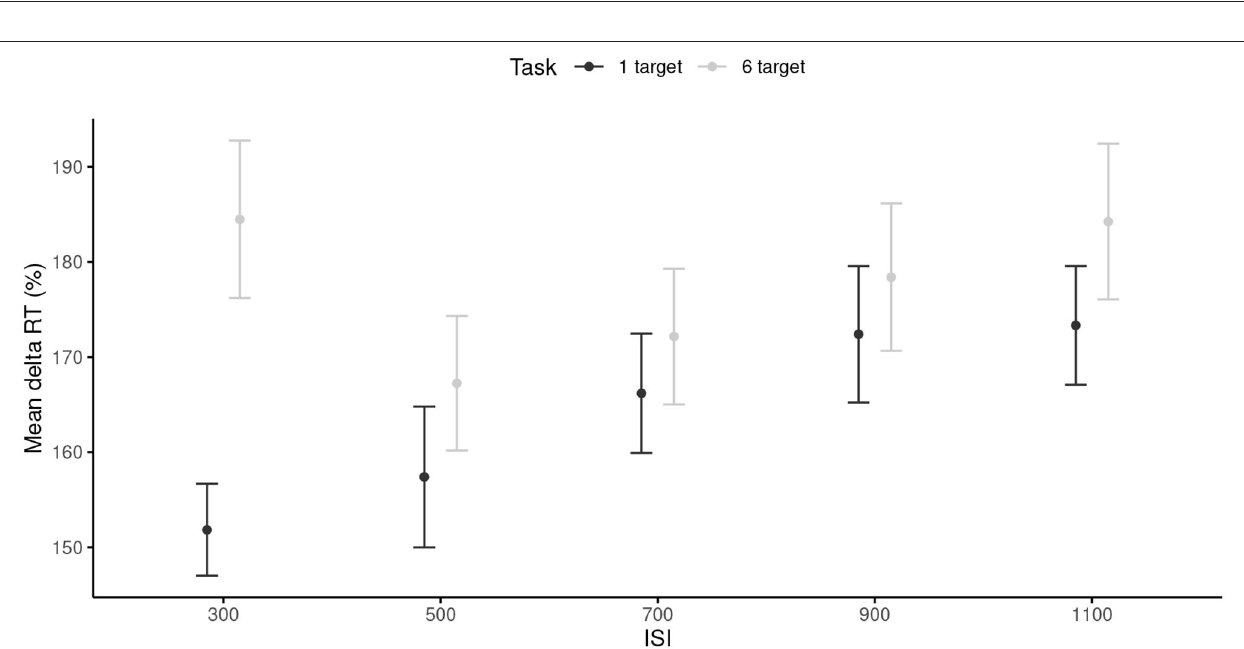
FIGURE 4 | Mean 1RTs for each inter-stimuli interval, and each task. 95% are represented in the figure by the error bars attached to each mean point. RT, reaction time; ISI, inter-stimuli interval.